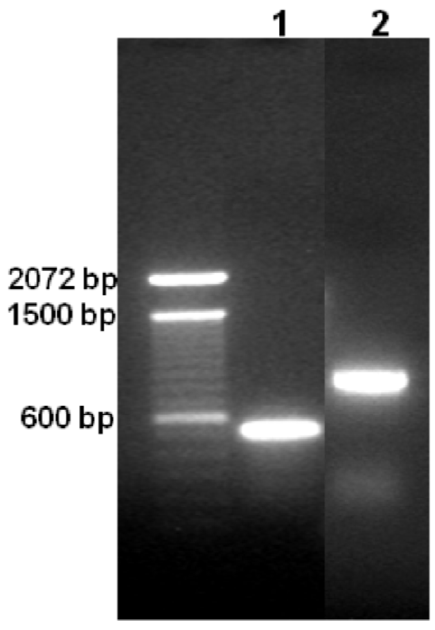
Figure 4. Agarose gel showing the products obtained when the mRNA fragment (lane 1) or the gene fragment (lane 2) were amplified using primers specific for both terminals of blad. The size of markers is indicated on the